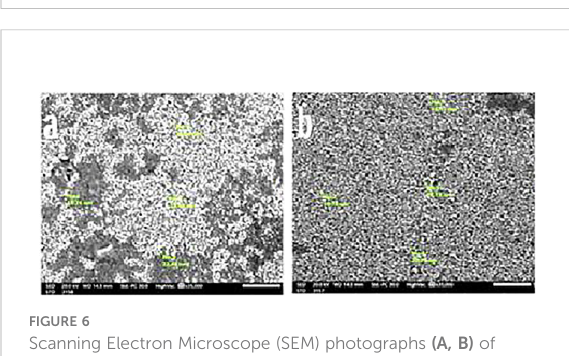
FIGURE 6 Scanning Electron Microscope (SEM) photographs (A, B) of PoSeNPs with measuring the diameter of PoSeNPs.